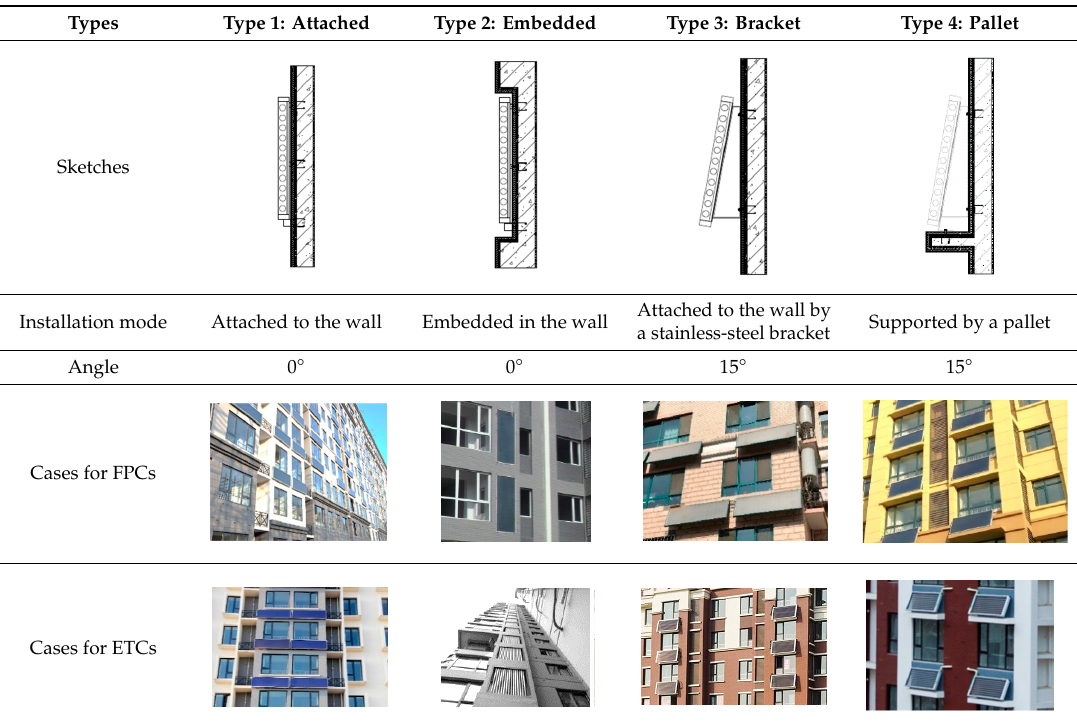
Table 5. Solar collectors installation modes on walls.